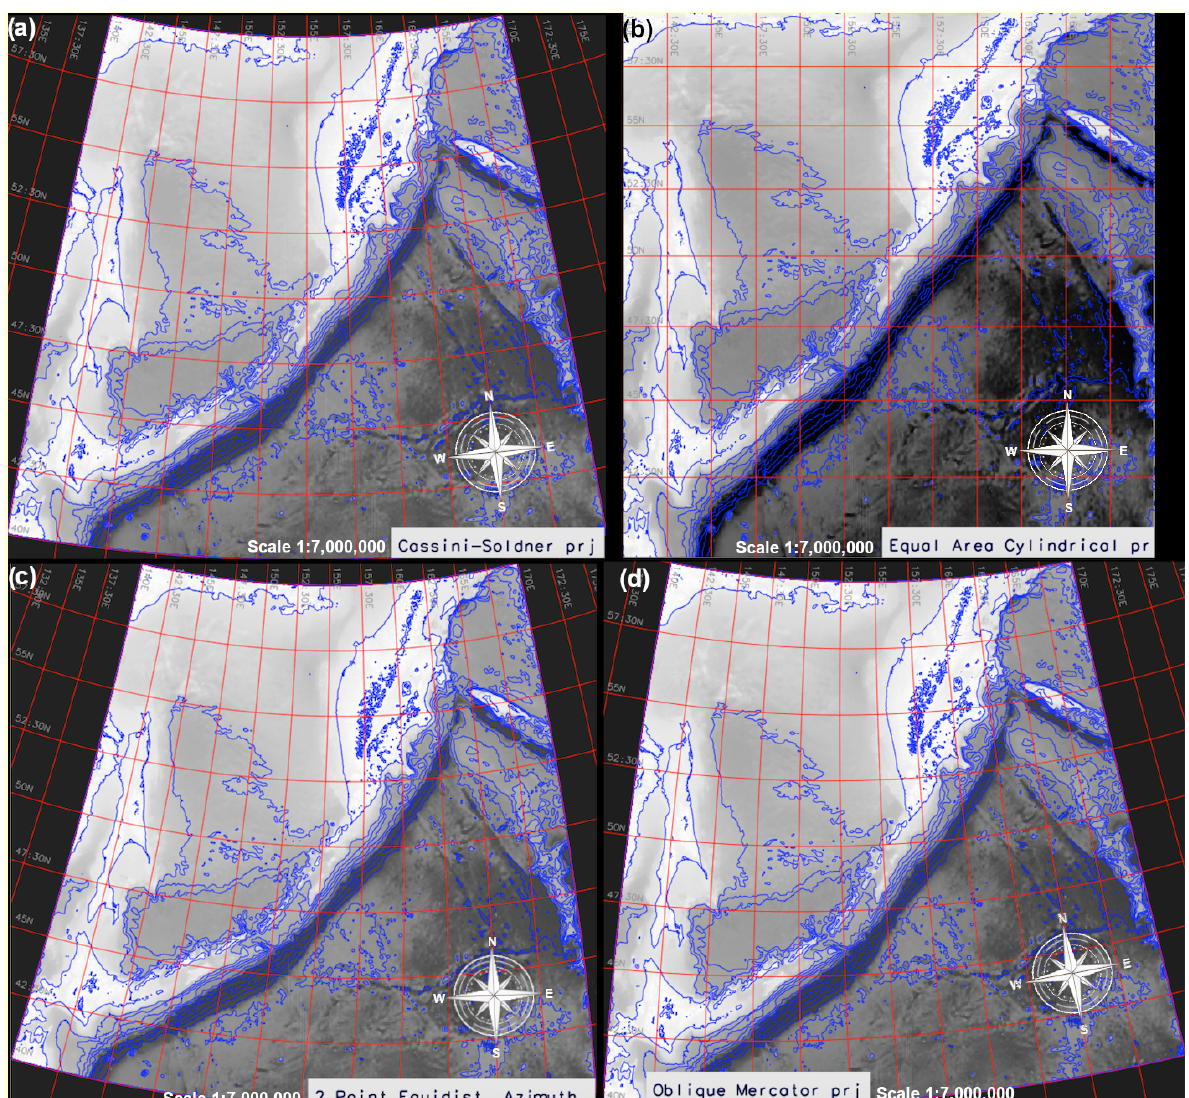
Figure 5. Comparison of the four maps visualized in GRASS GIS in four different cartographic projections transformed by the ‘gdalwarp’ GDAL utility and PROJ parameters. The projections from left to right, top to bottom are as follows: ( a ) Cassini–Soldner equirectangular; ( b ) equal area cylindrical; ( c ) two-point equidistant azimuthal; ( d ) oblique Mercator. Source: